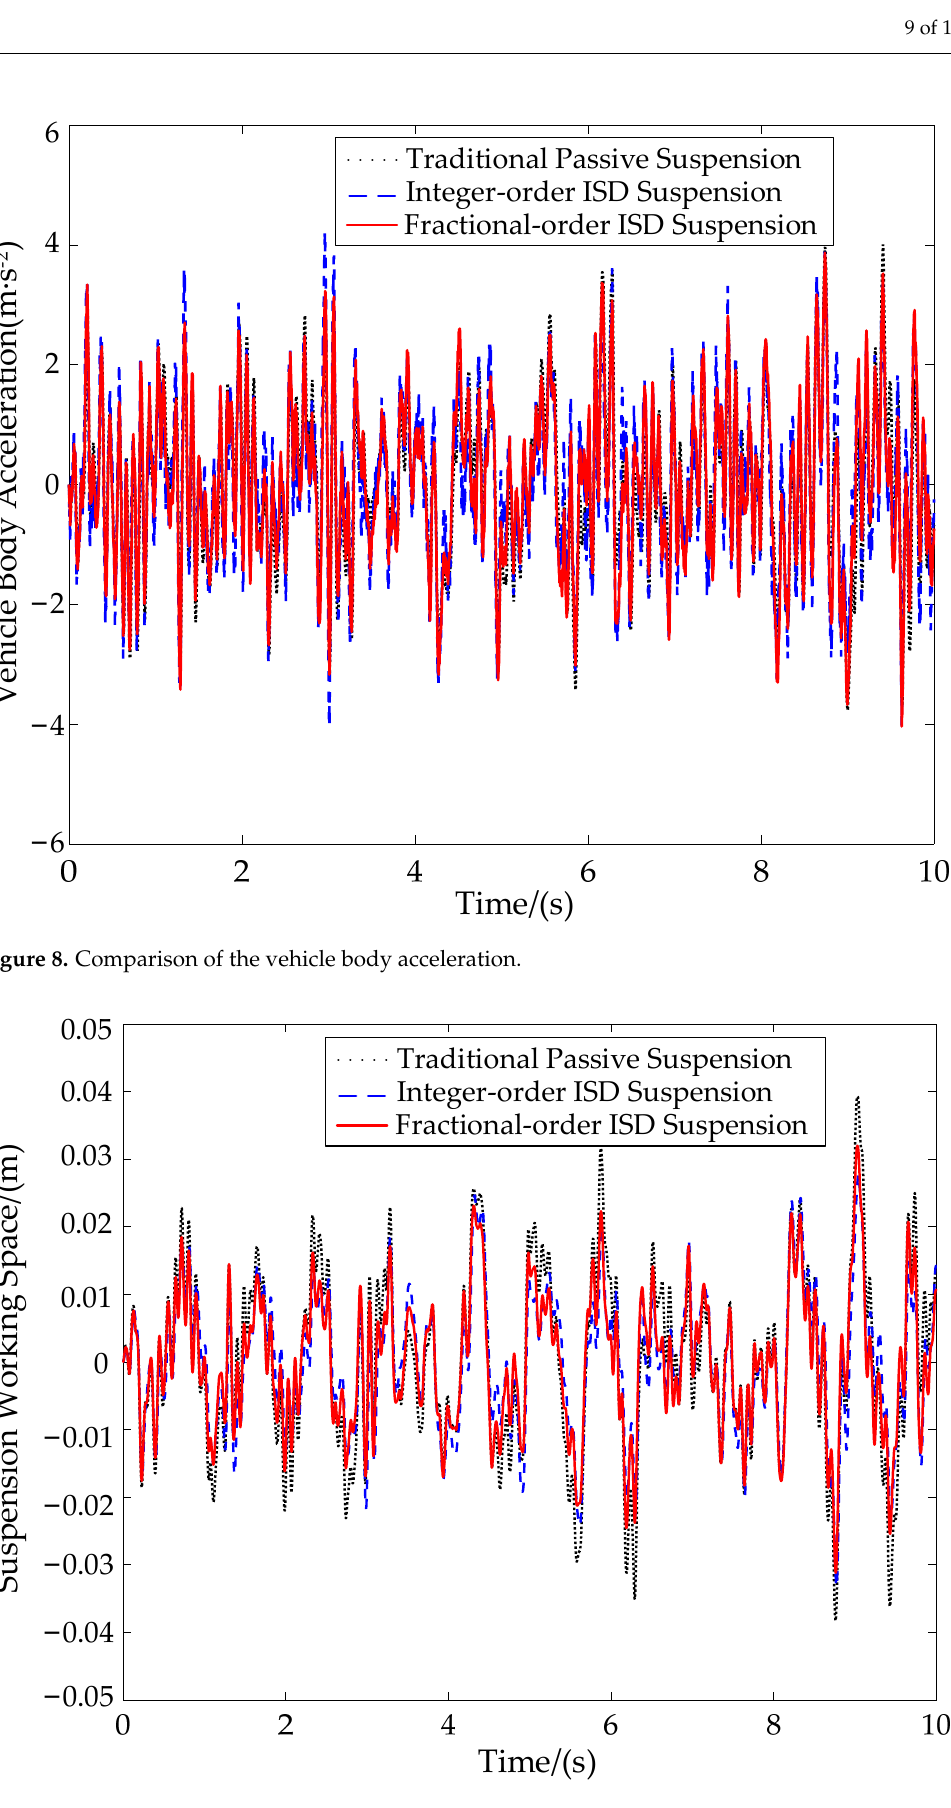
Figure 9. Comparison of the suspension working space.